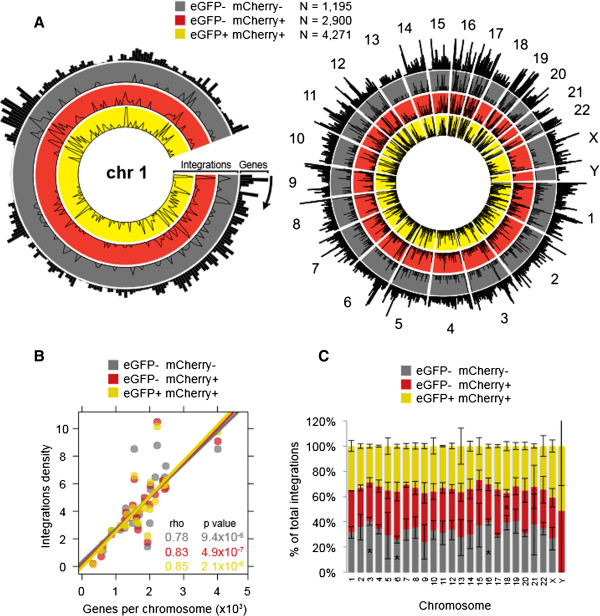
Productive and non-productive RGH infections occur at similar viral integration sites across the genome. A: Viral integration sites were mapped by 454 pyrosequencing in RGH infected Jurkat cells sorted for eGFP and mCherry expression. Data is shown for 1,195 eGFP- mCherry- integrations, 2,900 eGFP- mCherry+ integrations, and 4,271 eGFP+ mCherry+ integrations. Integrations and gene density across 1 Mb windows are plotted for chromosome one (left panel) and the entire genome (right panel). The outer track (black histogram) depicts gene density as annotated in the UCSC hg18 reference genome, while the inner tracks (colored line plots) indicate relative numbers of viral integrations. B: Integration density is plotted against gene density (genes per chromosome) for each sample. A linear regression line of the plotted points is shown. Samples were tested for significance by Spearman correlation. Rho coefficients and p values are listed. C: The proportion of total integrations in each chromosome is shown for each sorted cell population. Error bars represent standard deviations of triplicate experiments * p < 0.05 (Student’s T test).